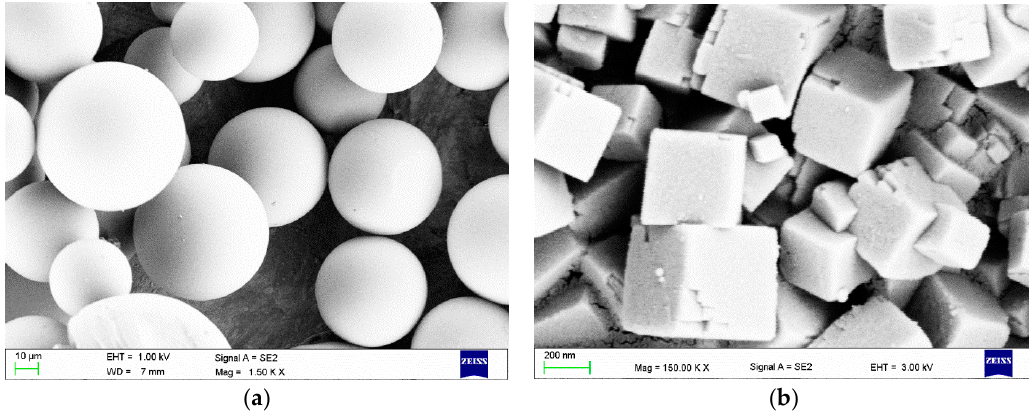
Figure 1. Representative scanning electron microscopy (SEM) images presenting the morphologies of the ( a ) poly(methyl methacrylate) (PMMA) powder; and ( b ) silver sodium hydrogen zirconium phosphate particles.